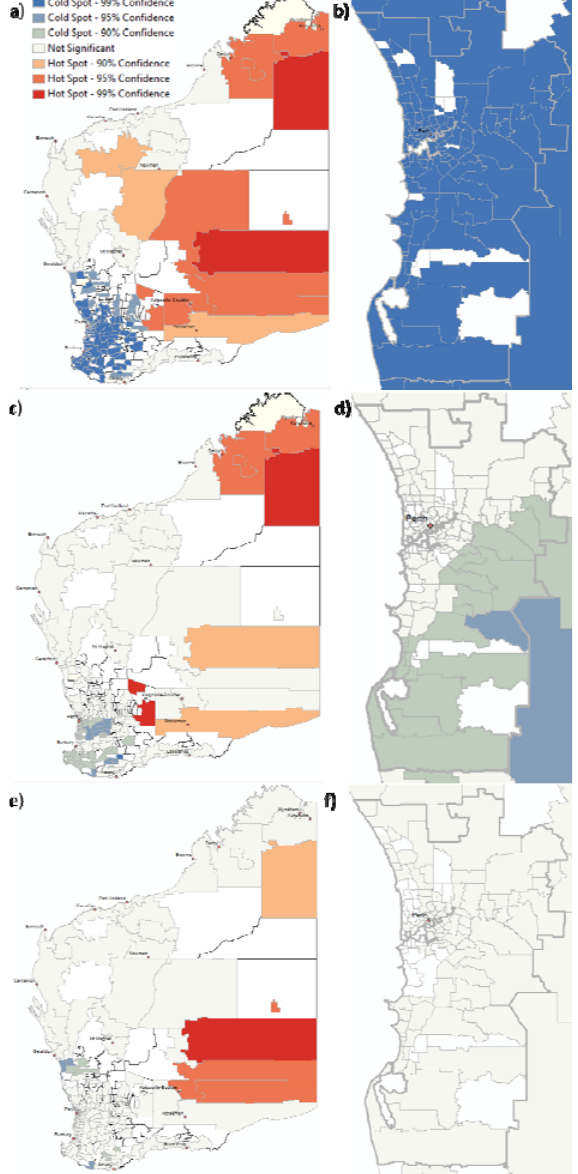
Figure 7. PPH hotspot analysis relative to State (a,b), ARIA- based regions (c,d) and Health Regions (e,f) Notice how, in Figures 7a and 7b, the metropolitan area has distinctly lower PPHs than the state average whereas the rural regions, particularly those that are more remote (eg. Eastern side of WA) have PPHs higher than the state average. This corroborates the visual inspection of Figures 6a and